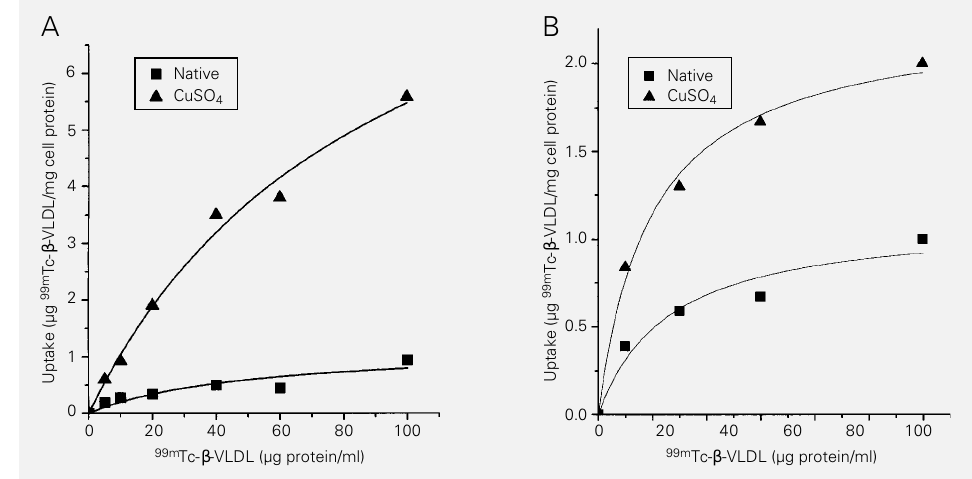
Figure 3 - Autoradiography for 99m Tc-ox-ß-VLDL uptake in the aorta. A , Aorta from a control rabbit; B , aorta from a hypercholesterolemic rabbit. The arrow indicates the accumulation of copper-oxidized 99m Tc-ß-VLDL in the atherosclerotic lesions of the aortic arch from choles- terol-fed rabbits.